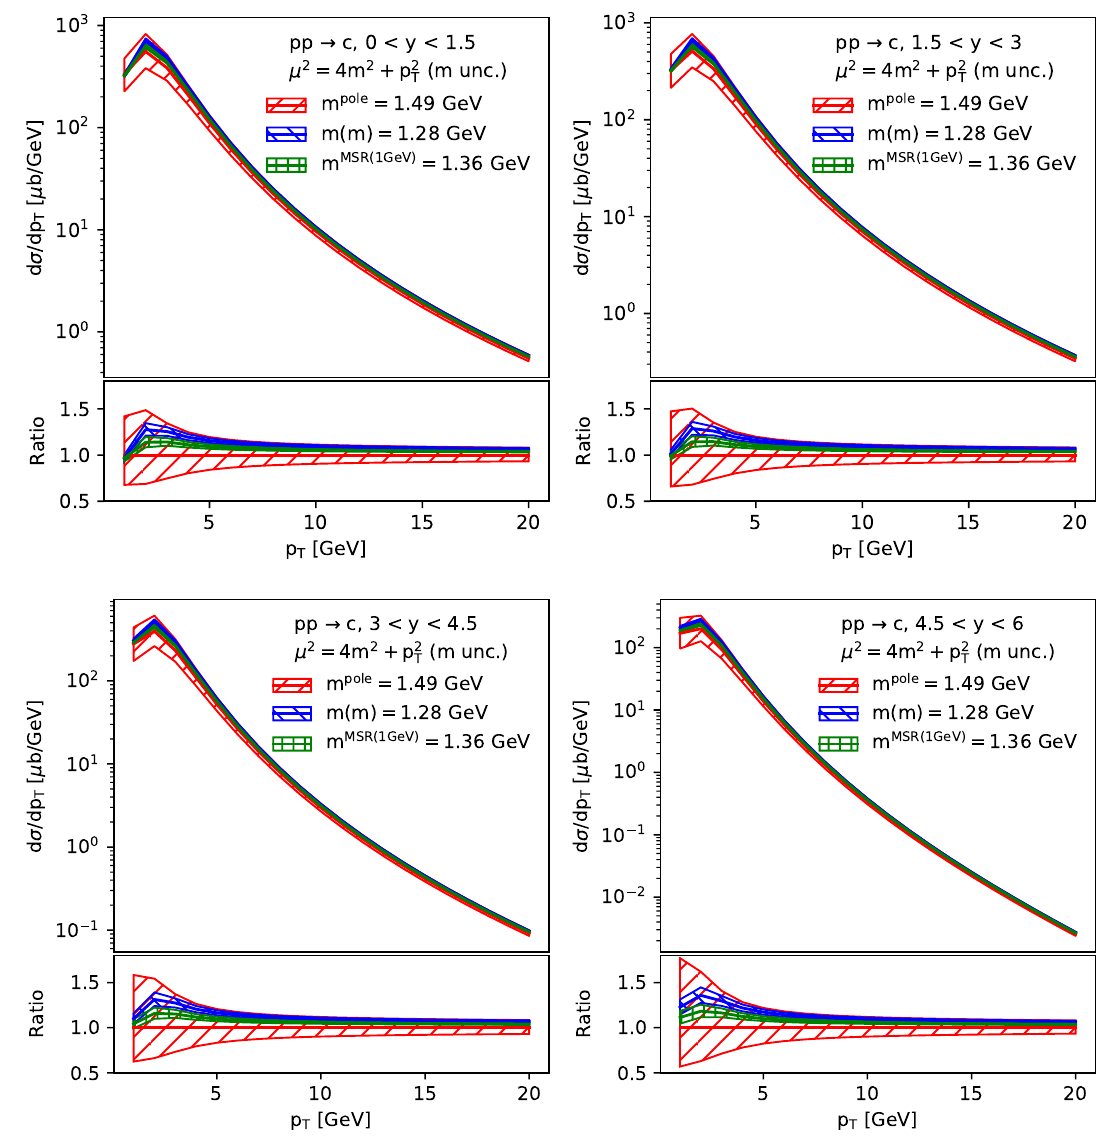
√ Figure 8 . The NLO differential cross-sections for charm production at the LHC ( s = 7 TeV) as a function of p T in intervals of y of the charm-quark in the pole and MS mass schemes. The bands denote variations of the mass values in the different schemes, m pole = 1 . 49 ± 0 . 25 GeV, c m c ( m c ) = 1 . 28 ± 0 . 03 GeV and m MSR = 1 . 36 ± 0 . 03 GeV. The lower panels display the theoretical c predictions normalized to the central values obtained in the pole mass